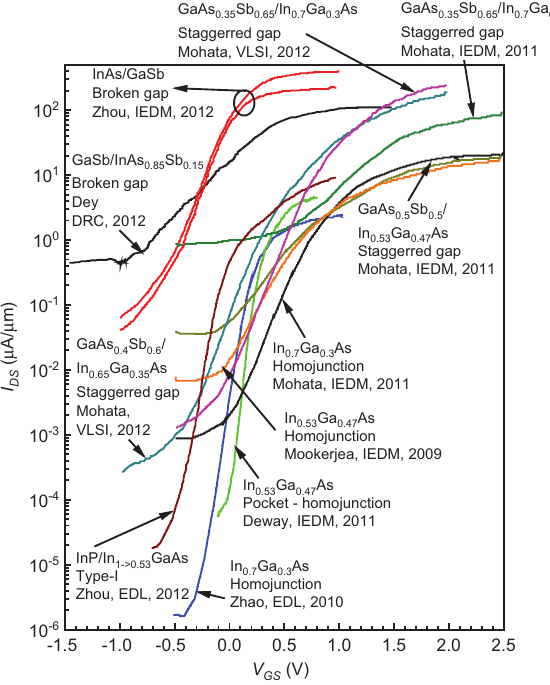
Figure 41 Summary of the transfer characteristics of experimental III-V TFET devices. An SS of 60 mV/dec is also denoted. Reprinted from Refs. [9, 15, 54, 55, 57, 74–77], with permission, from